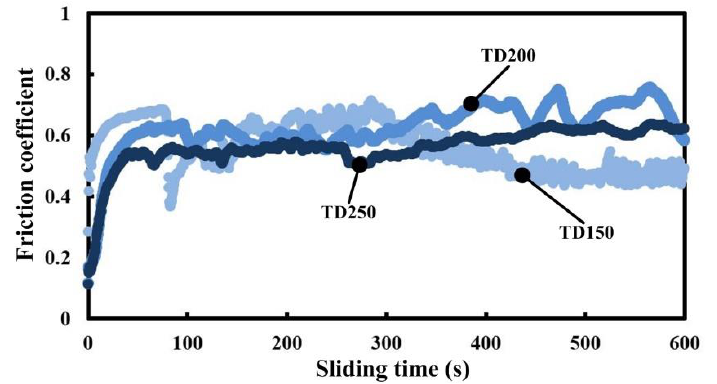
Figure 5. Average friction coefficients of different samples at different sliding speeds.